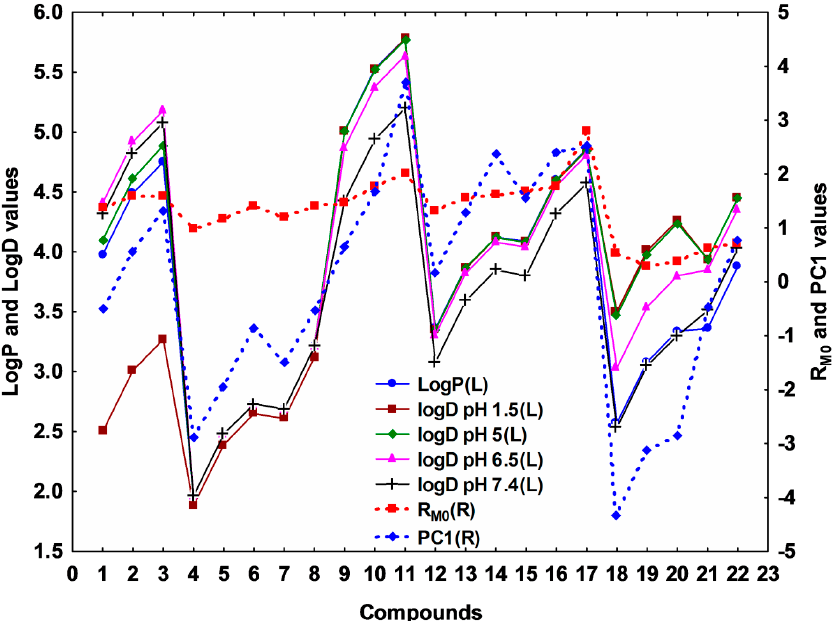
Figure 3. Relationship between computed LogP and LogD (calculated by the equally weighted calculation algorithm combining the three methods described in the Experimental Section) values profiles and experimental lipophilicity indices R M0 and PC1. The L or R information in the brackets refers to either left or right disposition of the values on the y axis.